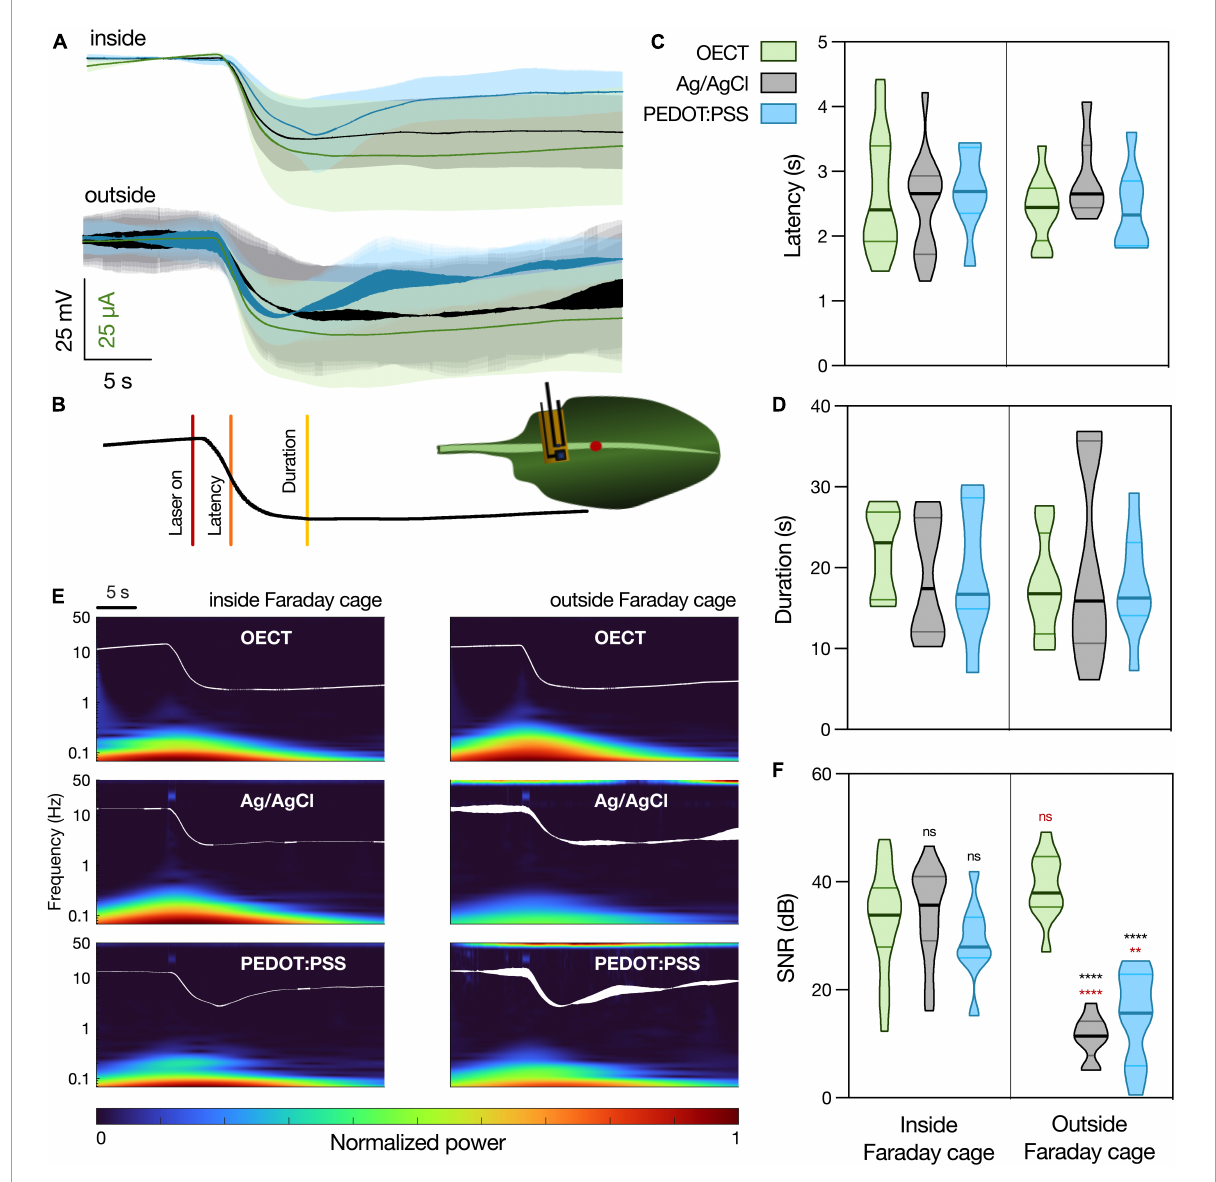
FIGURE4 Arabidopsis thaliana WASP triggered by laser recorded with different devices. (A) Average waveform recorded with the different devices, inside and outside the Faraday cage: OECT (green trace), Ag/AgCl electrode (black trace), and PEDOT:PSS electrode (blue trace). Data represented as mean ± 95% CI. N = 10–20 leaves from 3 to 5 different plants. (B) Schematic representation of experimental setup. Laser was shined on a leaf for 1 s at 50% laser power and the different devices were in contact with the leaf less than 1 cm away, in a proximal direction, from the laser. The parameters considered for the characterization of the WASP were latency (time to reach half of maximal amplitude) and duration (time from laser on to recovery). (C) Quantification of latency and (D) duration of WASPs recorded with the different devices. No statistically significant differences were found. N = 7–18. (E) Time-frequency analysis of the average waveform acquired with the different devices, inside and outside of the Faraday cage. (F) Quantification of SNR for the different waveforms, N = 9–19. ** p < 0.01, **** p < 0.0001 using a two-way ANOVA considering the parameters “device” and “Faraday cage,” followed by Tukey’s multiple comparison test. In black, differences within the same “cage” condition; in red, differences in the same “device” condition. In (C , D , F) , data are represented in violin plots, where the width of the shaded area represents the proportion of data points at any given zone, with lines at median and quartiles.